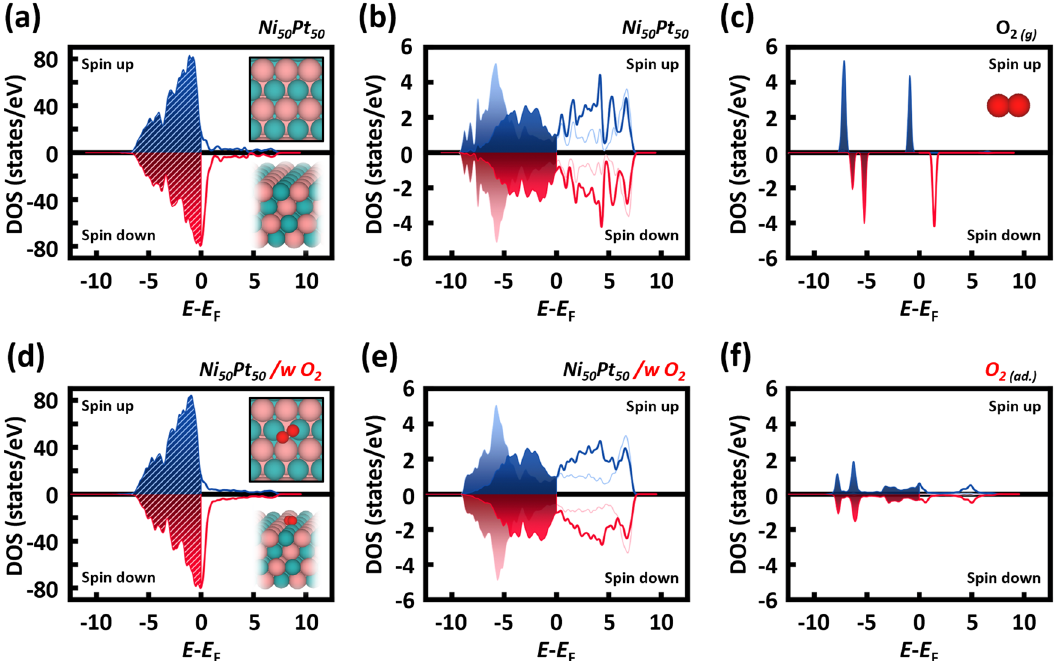
Fig. 2 Partial DOS for the Ni 50 Pt 50 (111) system before and after O 2 adsorption. The s -states (light), p -states (dark), and d -states (patterned) DOS plots are shown. Occupied states are fi lled in color; unoccupied states are depicted by lines. a – c The shape of states without adsorbed O 2 on the Ni 50 Pt 50 (111) surface and O 2 gas phase in a vacuum. d – e The shape of states of the Ni 50 Pt 50 (111) surface and O 2 of the adsorbed experimental XRD patterns. From this process, we intended to predict the possibilities and tendencies of alloys for use as H 2 O 2 direct synthesis catalysts. Nevertheless, because the synthesized sample could include random solid-solution structures, there is the potential for discrepancies between theory and experiment. We further characterized the NP samples by high-angle annular dark- fi eld scanning transmission electron microscopy (Fig. 4 and Supplementary Figure 2~9). The elemental color mapping and overlay clearly indicate the homogeneous mixing of elements in each NP. The mean diameters of the alloyed NPs were 3.4 ± 0.4 nm (Pd